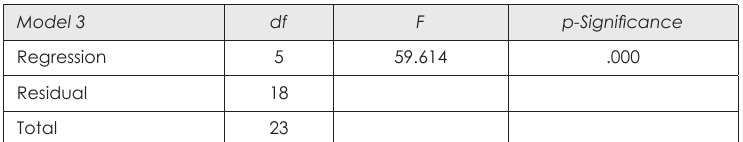
Model 3 ANOVA test results